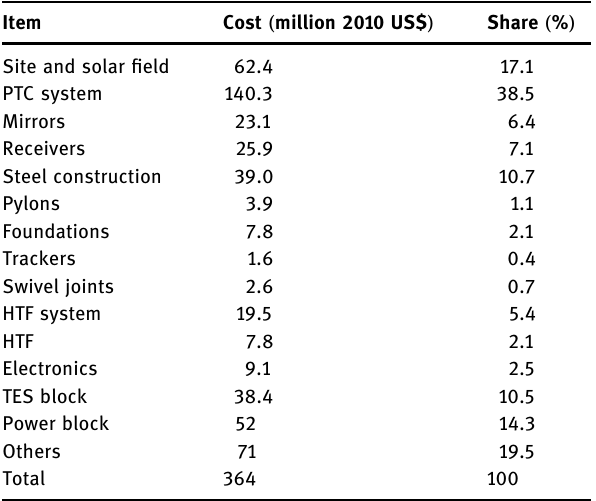
Table 12: CAPEX distribution for a CSP plants with PTCs [ 3 ]